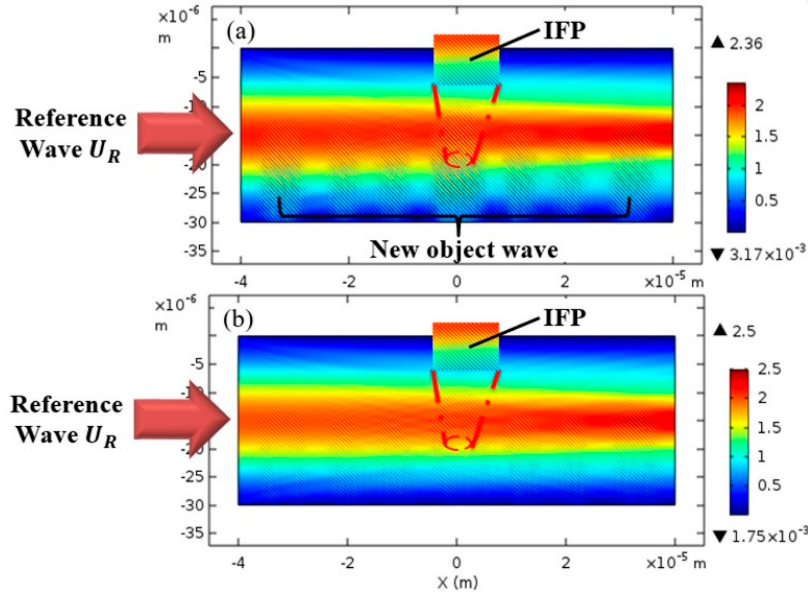
Figure 6. The decryption strength and electric field at: ( a ) 𝜆 (cid:3019) = 632.8 nm , ( b ) 𝜆 (cid:3019) = 601.2 nm . (Inset: the IFP with at a 45-degree angle).